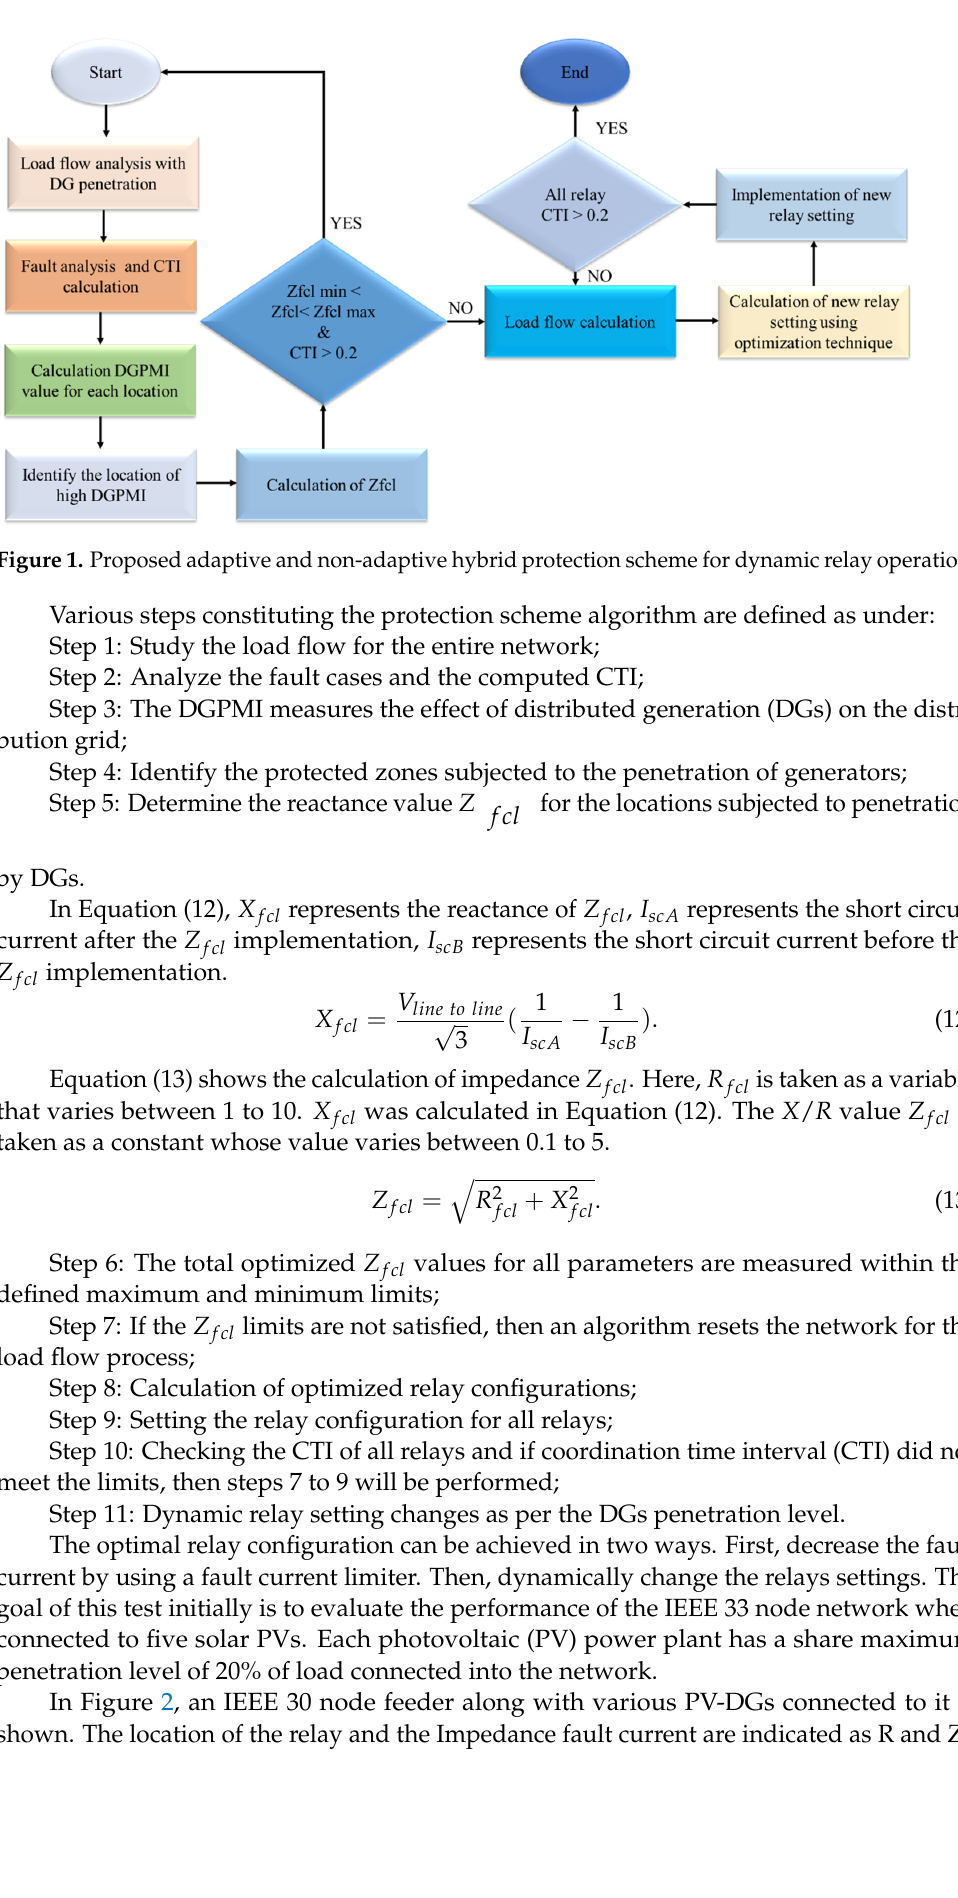
Figure 2. IEEE 33 node model along with Solar PV-DGs and